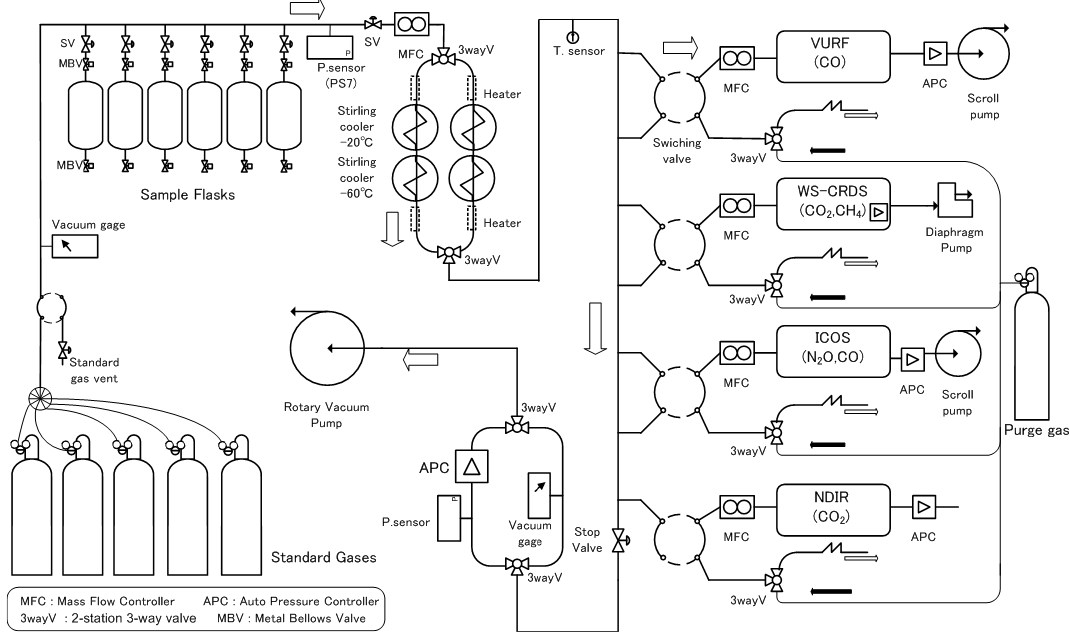
Fig. 1. Schematic diagram of the trace gas measurement system for flask air samples at JMA. Details of the air flow and measuring procedure are described in the